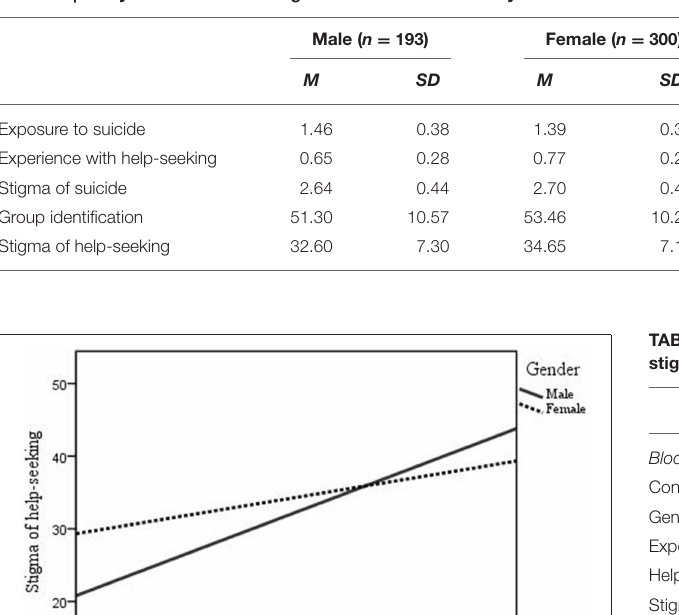
TABLE 2 | Analysis of variances for gender differences in study variables.